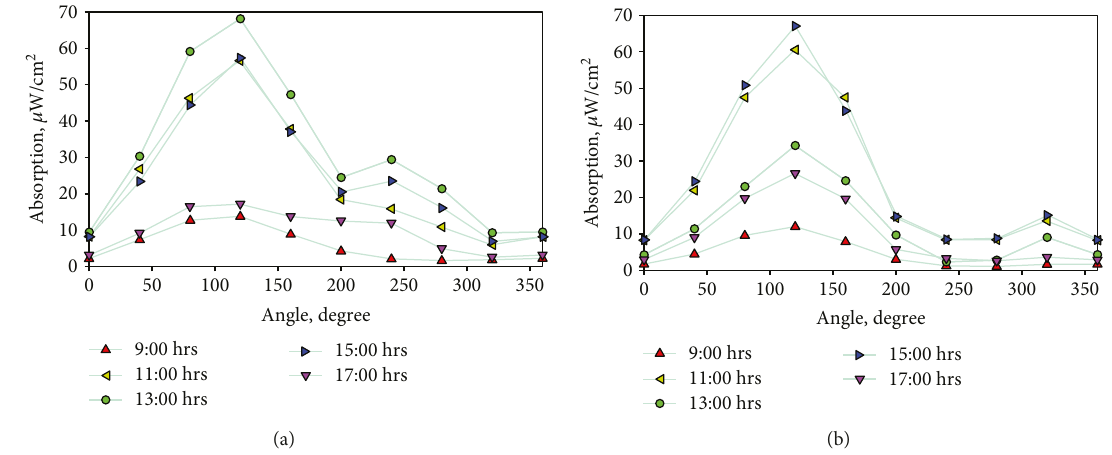
Figure 8: Power fl ux absorption distribution for tube 3, in con fi guration 2, for di ff erent hours. June 21st (left) and December 21st